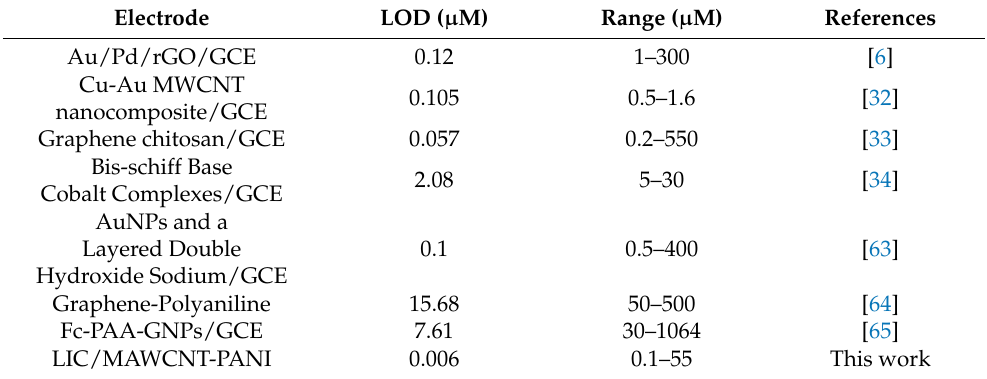
Table 2. Performance parameters of different electrochemical sensor methods for 4-AP detection.